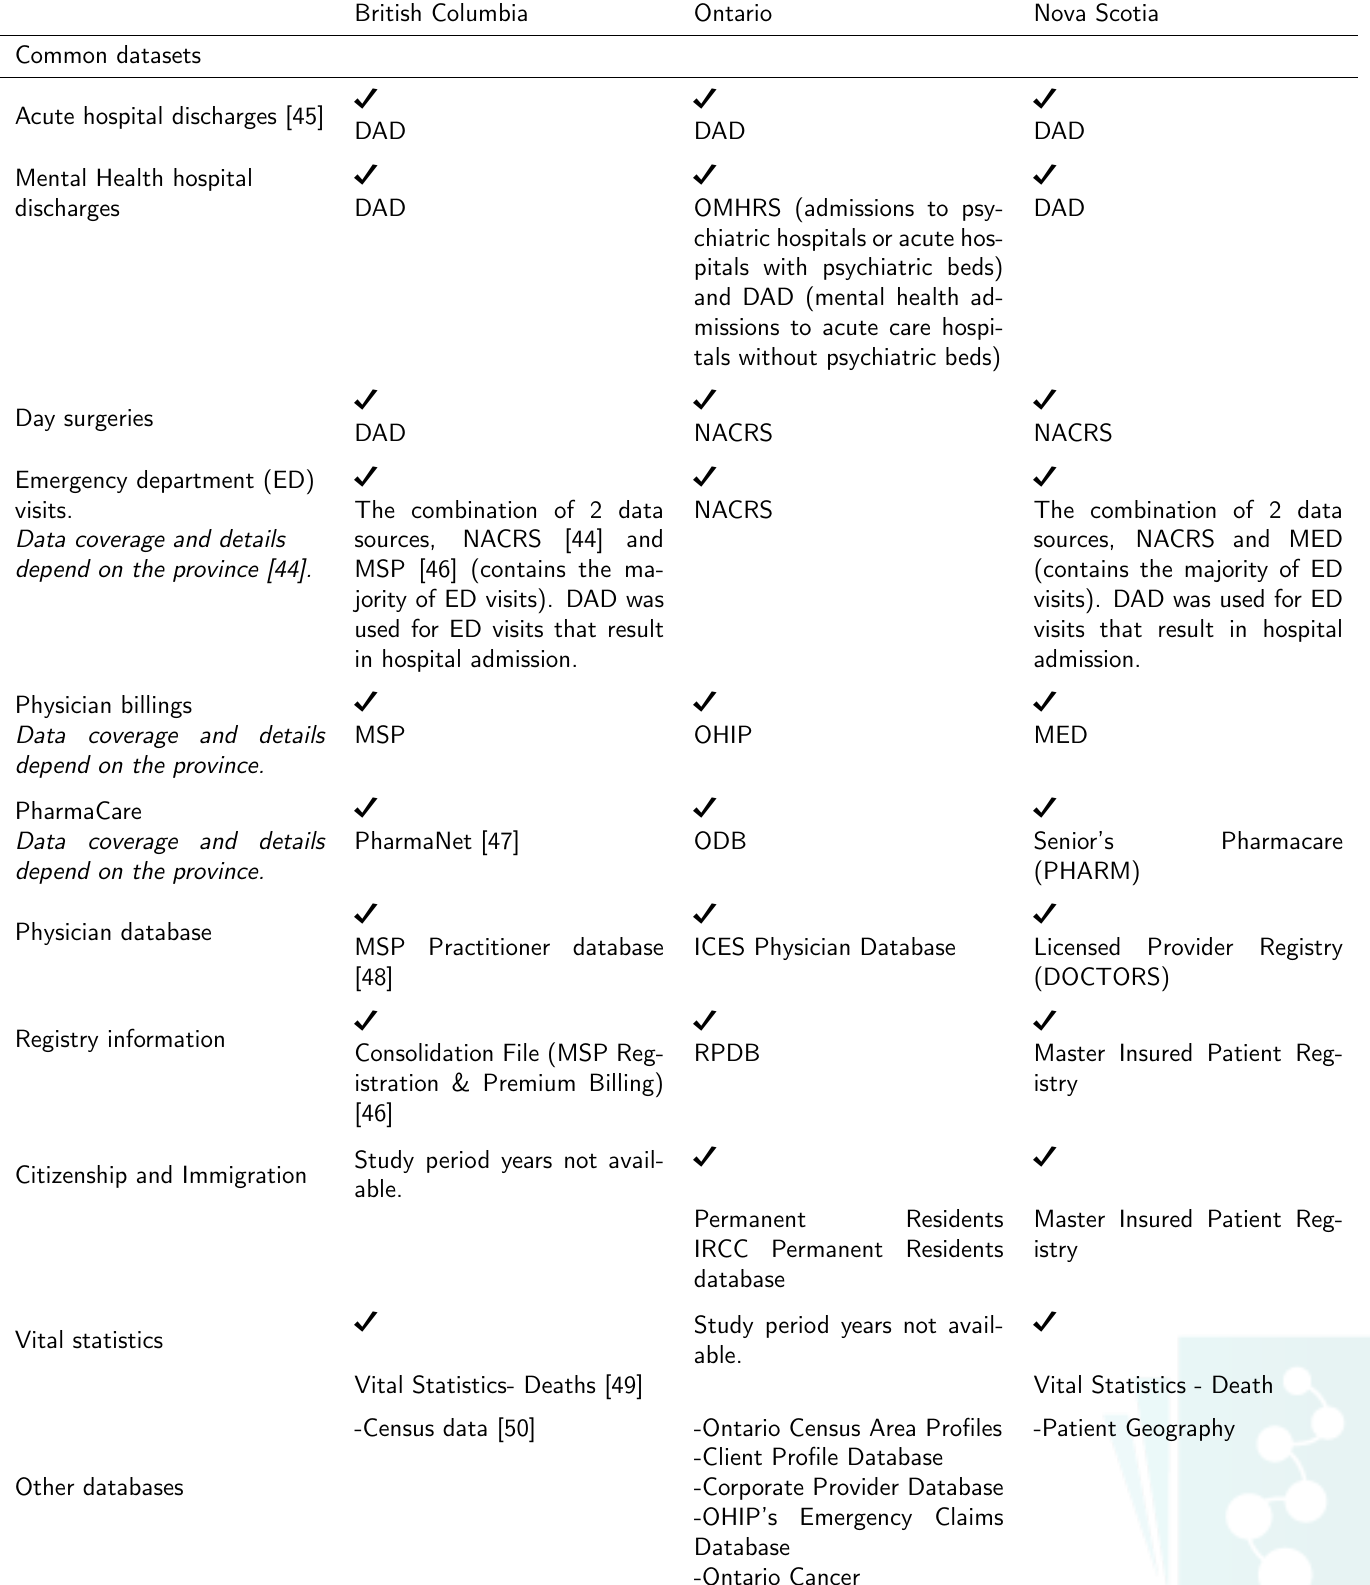
Table 1: Databases used in the TRANSFORMATION Study British